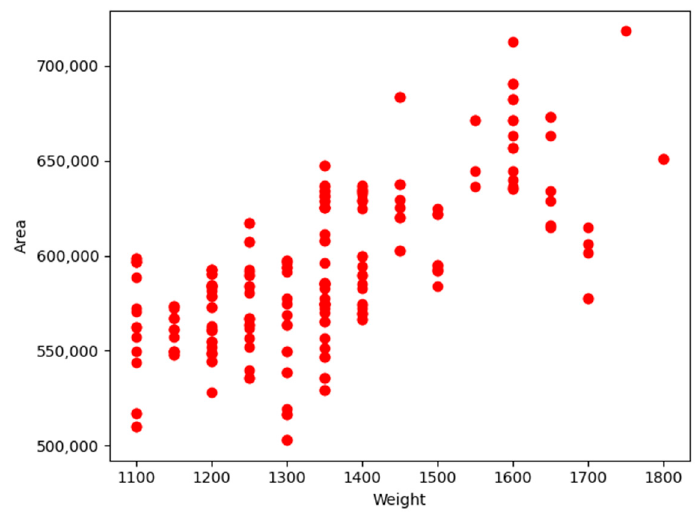
Figure 8. Distribution of bird weights and area occupied.